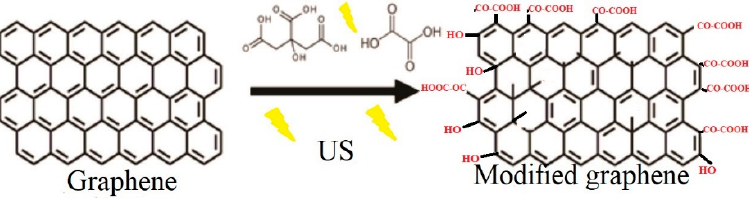
Figure 8. Scheme for the graphene modification under the action of organic acids and ultrasonic radiation.